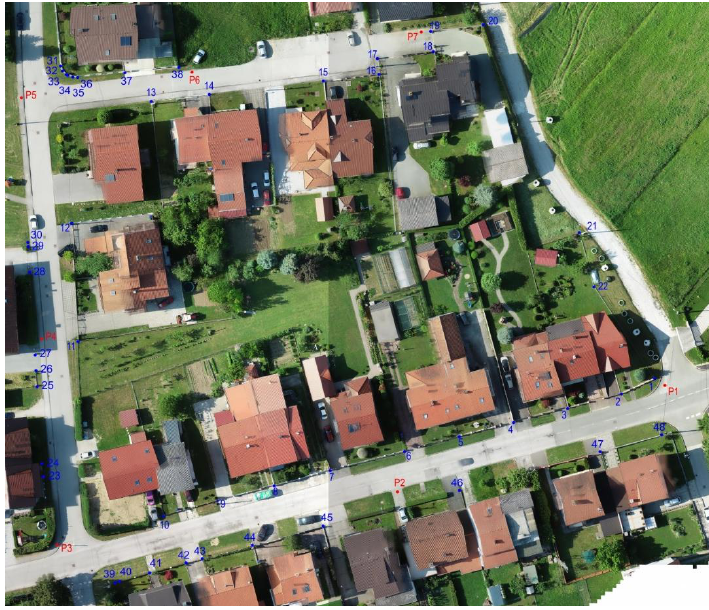
Figure 4. Study site in the city of Jastrebarsko, Croatia.